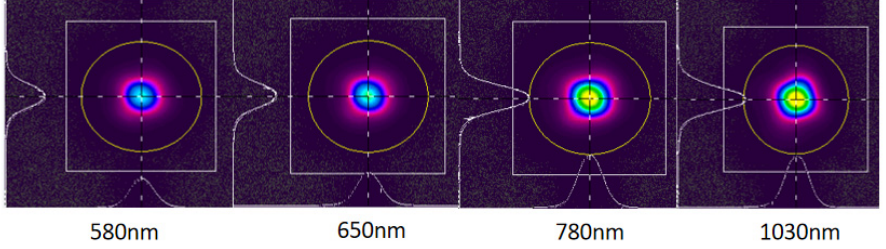
Figure 9. The beam distribution at different wavelengths in 10 m GRIN fiber with 30 W pump power.